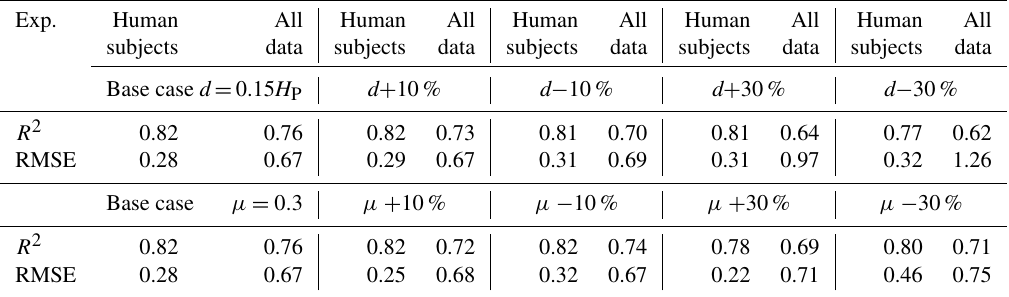
Table 4. Sensitivity of the goodness of fit to the parameters d and µ . Exp. Human All Human All Human All Human All Human All subjects data subjects data subjects data subjects data subjects data Base case d = 0.15 H P d + 10% d − 10% d + 30% d − 30% R 2